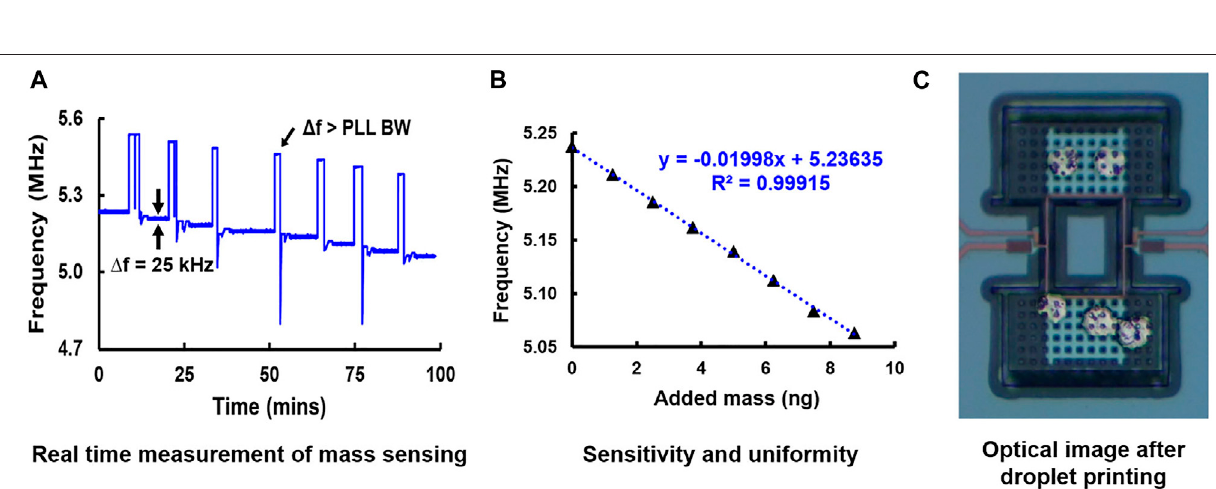
FIGURE 11 | II-bar TPO performance evaluation for mass sensing. (A) Real-time frequency measurements for the printing of seven Ag 1 pL droplets. The impact force causes the frequency shift to exceed the PLL bandwidth. (B) Frequency vs. added mass shows excellent linearity with R 2 of 0.999 and mass sensitivity of 20 kHz/ ng. (C) OM image of the Ag particles deposited on the proof mass.